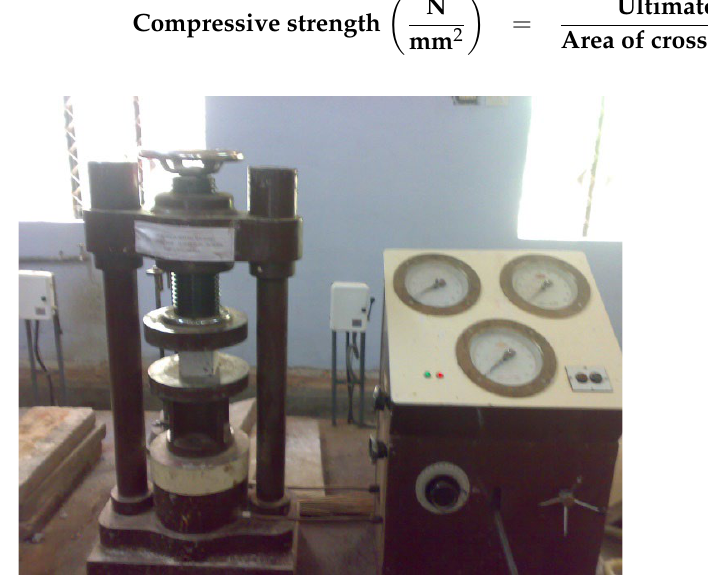
Figure 1. Compressive Strength Test setup.